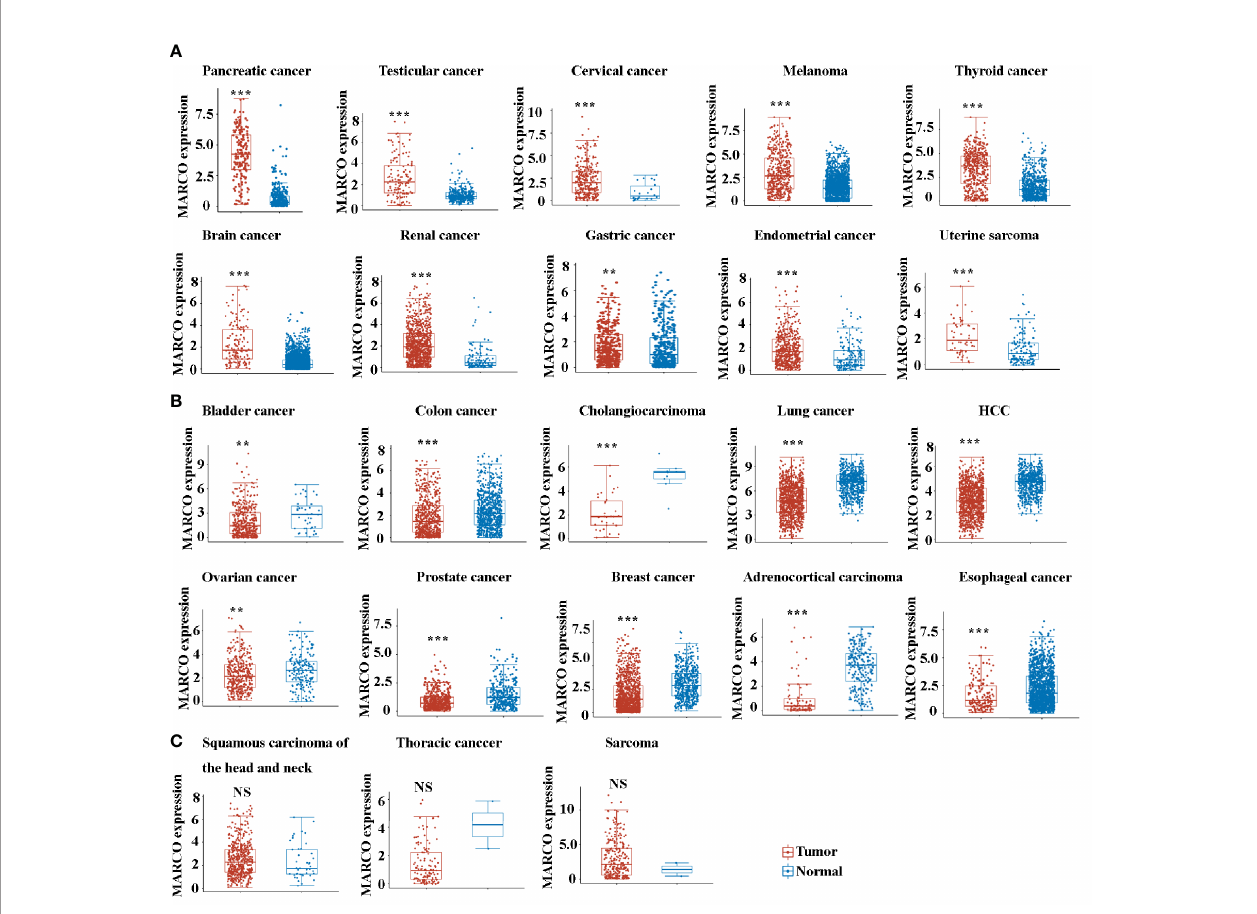
FIGURE 5 | (A) The up-regulated mRNA expression of MARCO across many types of solid tumors from the TCGA database. (B) The down-regulated mRNA expression of MARCO across many types of solid tumors from the TCGA database. (C) The unchanged mRNA expression of MARCO across many types of solid tumors from the TCGA database. ** P < 0.01, *** P < 0.001. NS means no signi fi cant